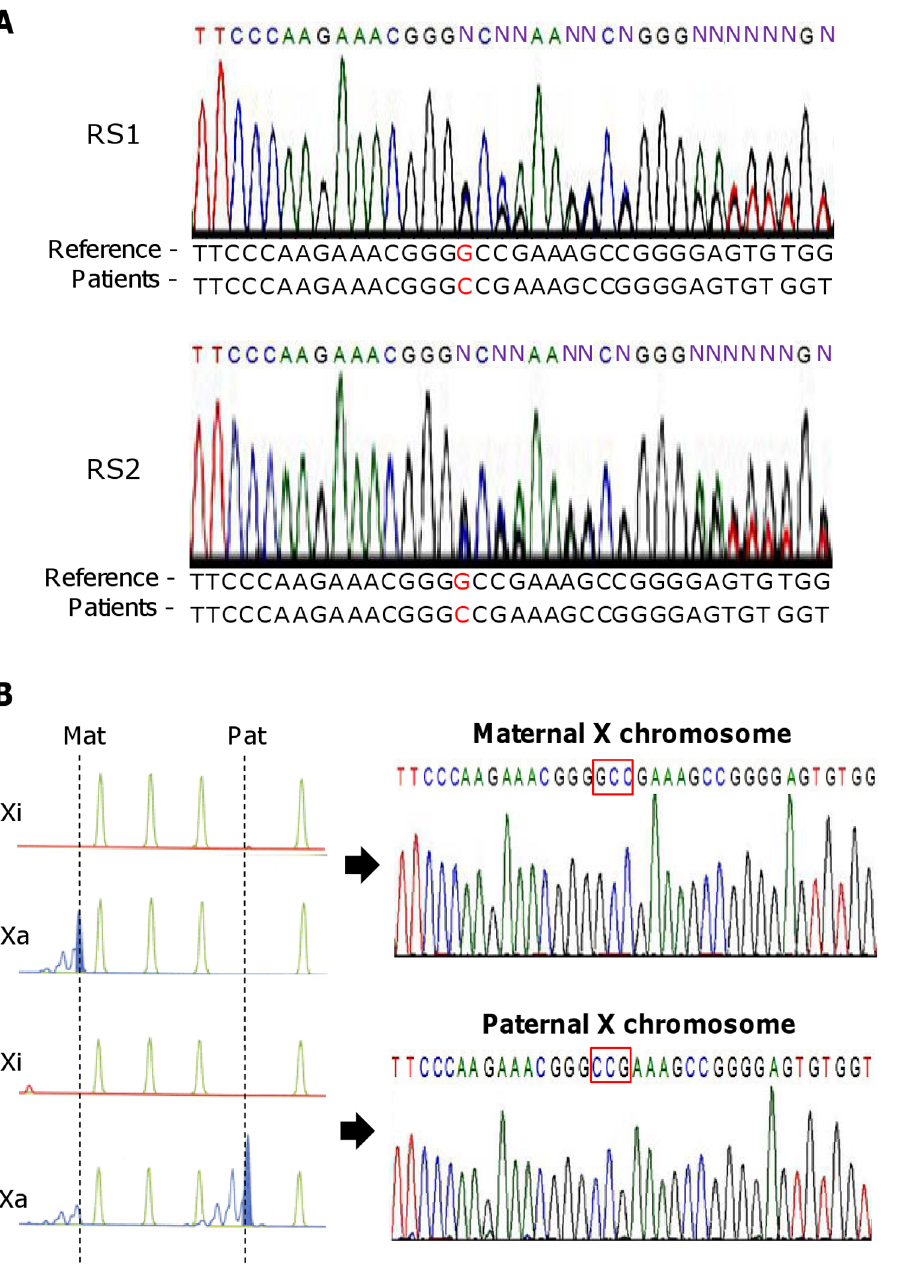
Figure 1. Mutation analyses of the MECP2 gene in the RTT twins. (A) DNA sequencing demonstrated that both twin 1 (RS1) and twin 2 (RS2) had the same mutation (1 bp ‘‘G’’ deletion in exon 4). (B) Determination of the parental origin of the mutation. (Upper) Sequencing of MECP2 in a somatic hybrid cell clone carrying an RS1 derived maternal X chromosome. (Lower) Sequencing of MECP2 in a somatic hybrid cell clone carrying an RS1 derived paternal X chromosome. The parent of origin of the X chromosome was determined by the HUMARA X chromosome inactivation